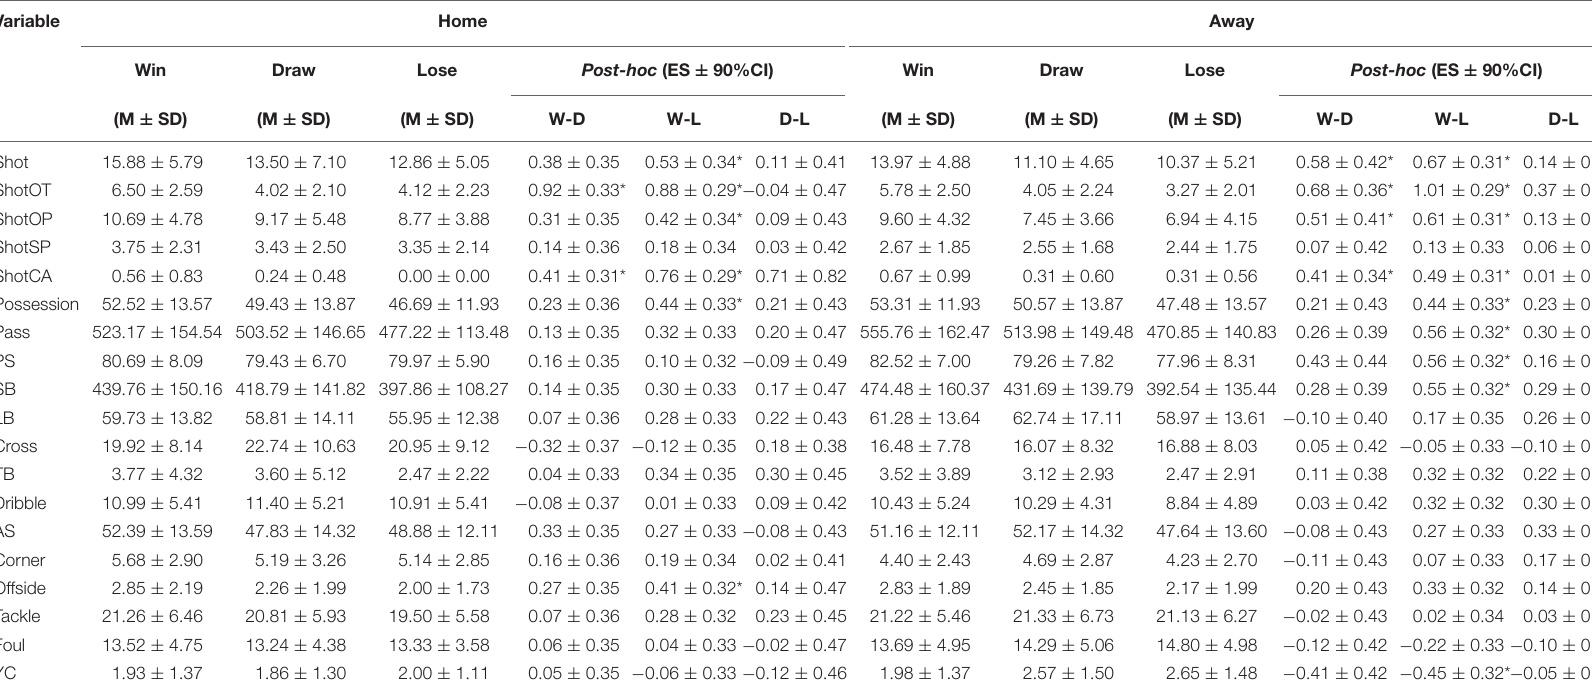
Descriptive statistics of teams in Tables 2 – 5 are presented as mean ± standard deviation (M ± SD). Effect sizes (ES) are presented as the magnitude of the true difference in means ± 90% confidence interval. Asterisks indicate that the p-value is lower than the significance level of 0.05. Abbreviations: ShotOT, shot on target; ShotOP, shot from open play; ShotSP, shot from set piece; ShotCA, shot from counter-attack; PS, pass success; SB, short ball; LB, long ball; TB, through ball; AS, aerial success; YC, yellow